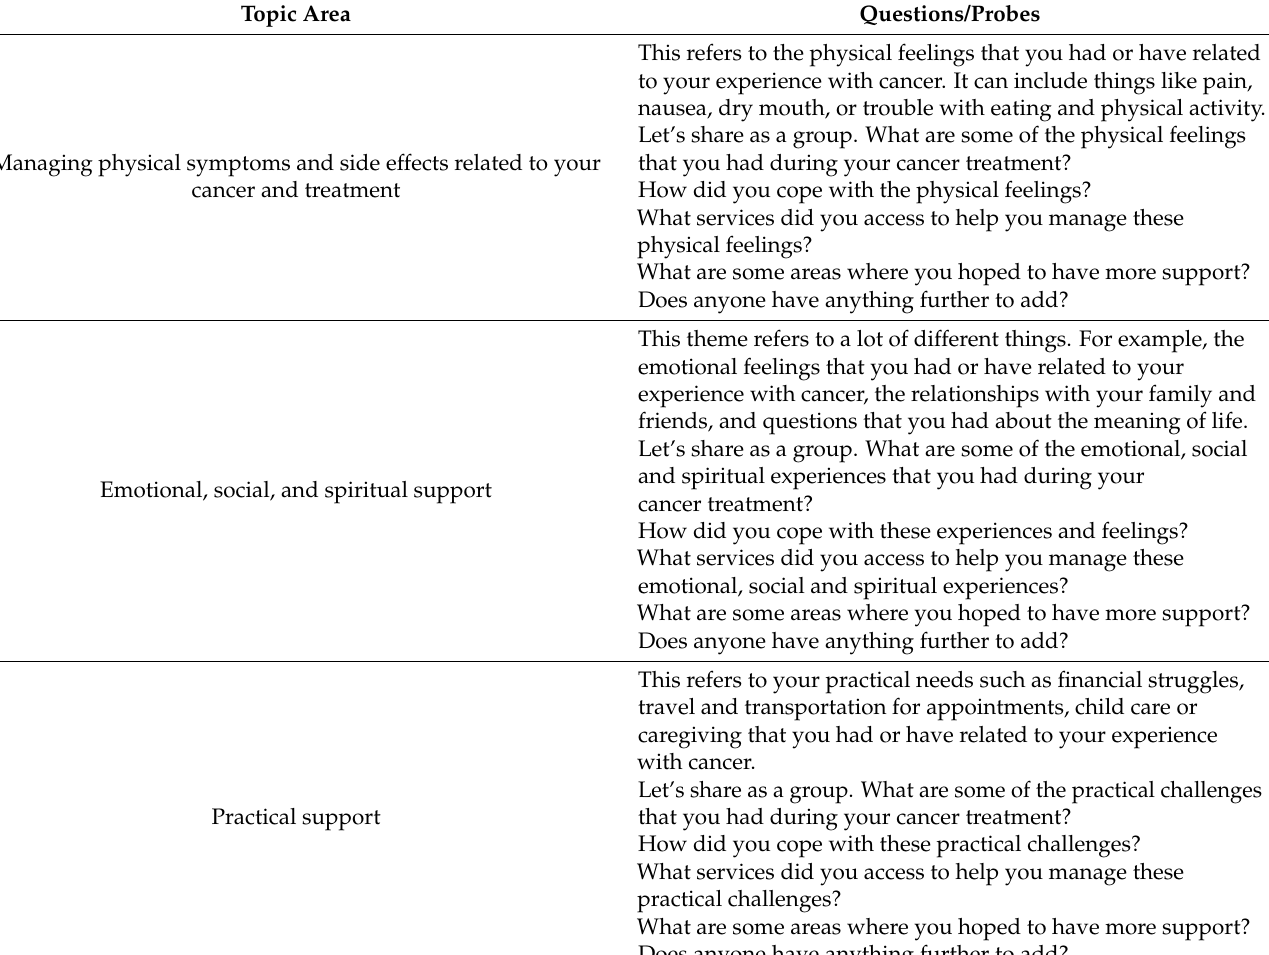
Table 1. Focus Group